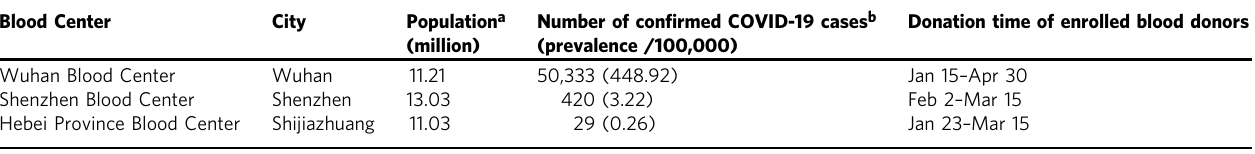
Table 4 The population size, number of con fi rmed COVID-19 cases and donation time of enrolled blood donors in three different